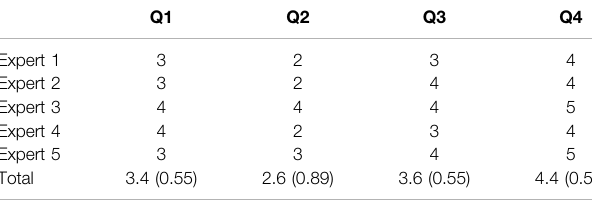
TABLE 5 | Questionnaire results from two